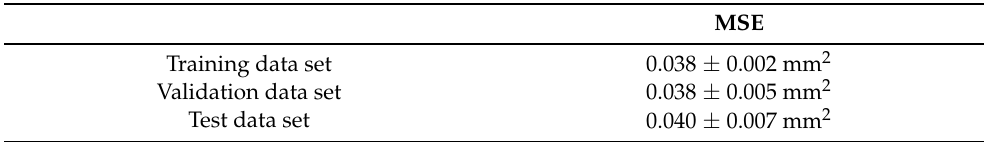
Table 1. Mean values and standard deviations of the MSEs obtained by cross-validation for the data fusion between EC and US.